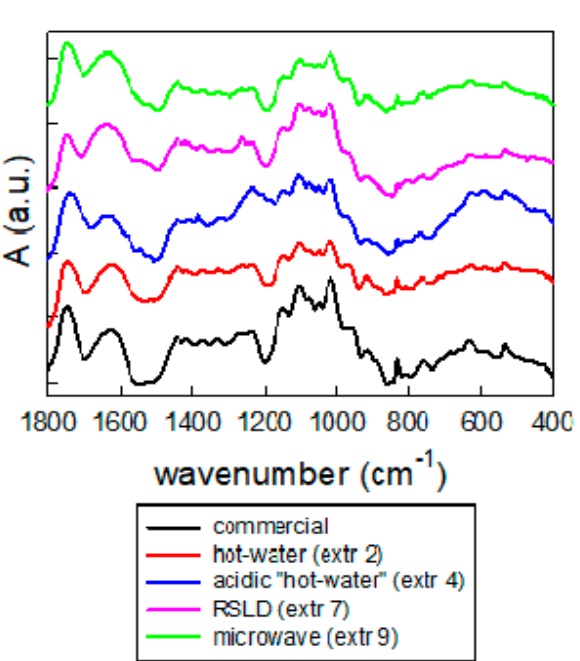
Figure 3. Fourier Transform Infrared (FTIR) spectra of standard commercial pectin; “hot water” extracted pectin in the absence (extraction 2) of and in the presence of citric acid (extraction 4); Rapid Solid Liquid Dynamic (RSLD) extracted pectin (extraction 7) and microwave extracted pectin (extraction 9).